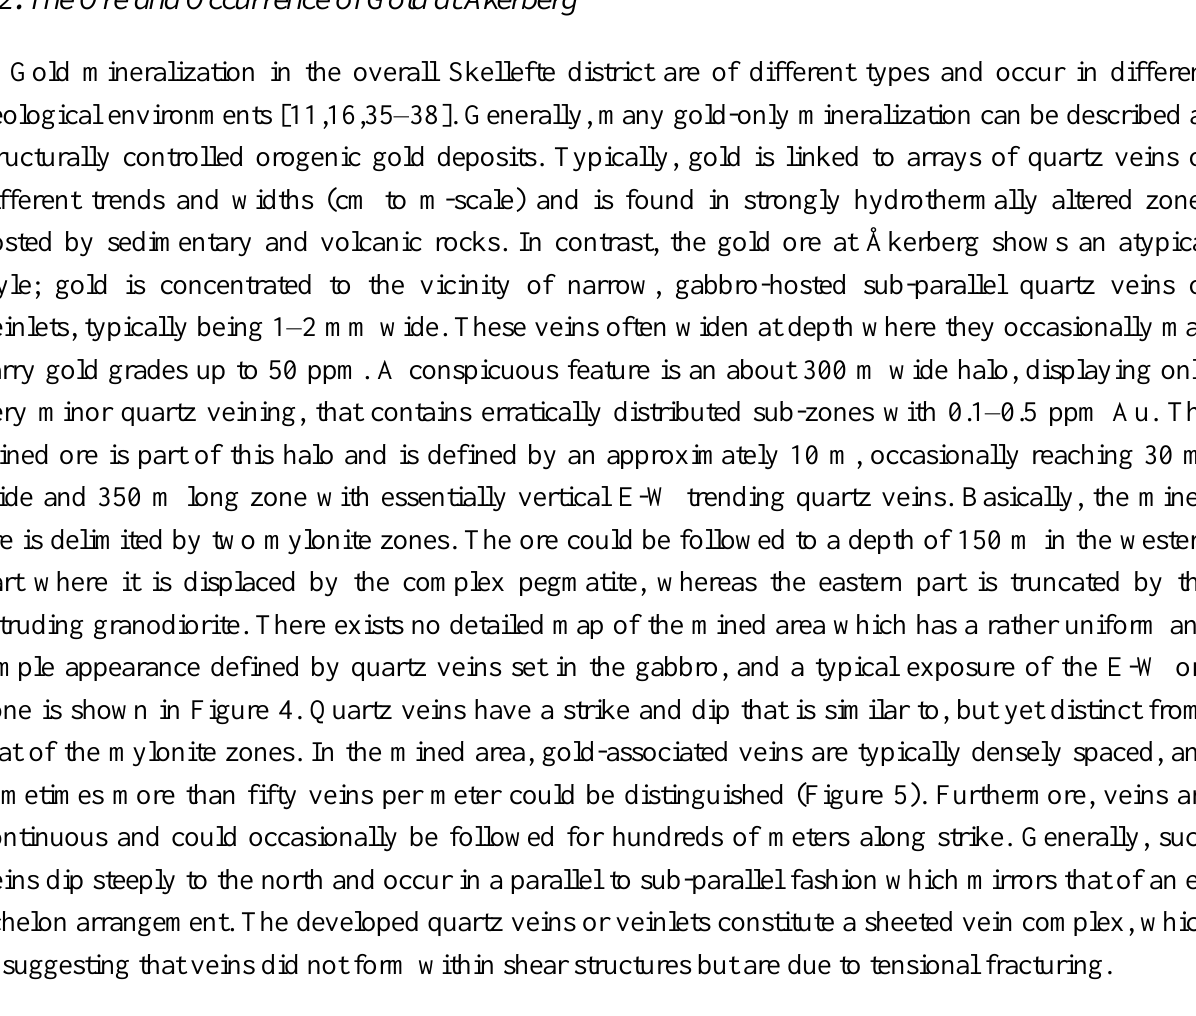
Figure 4. Mineralised gabbro outcrop (compass for